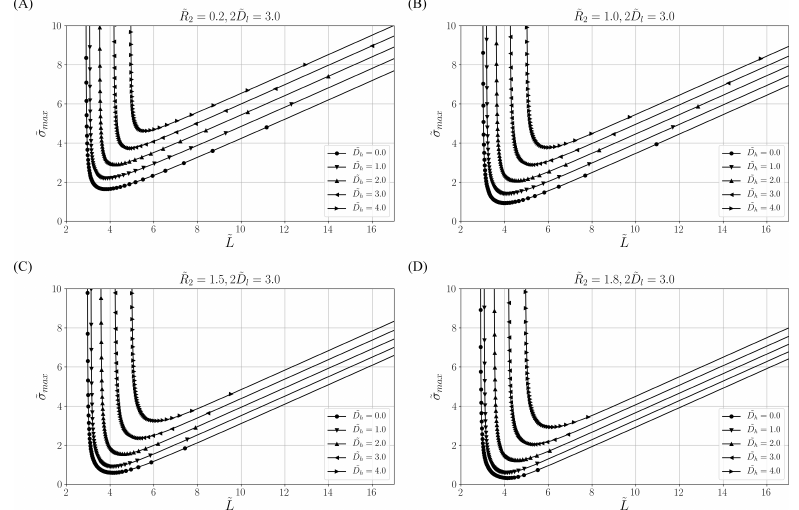
Figure 9. Plot of calculated ˜ σ max and ˜ L when ˜ D h